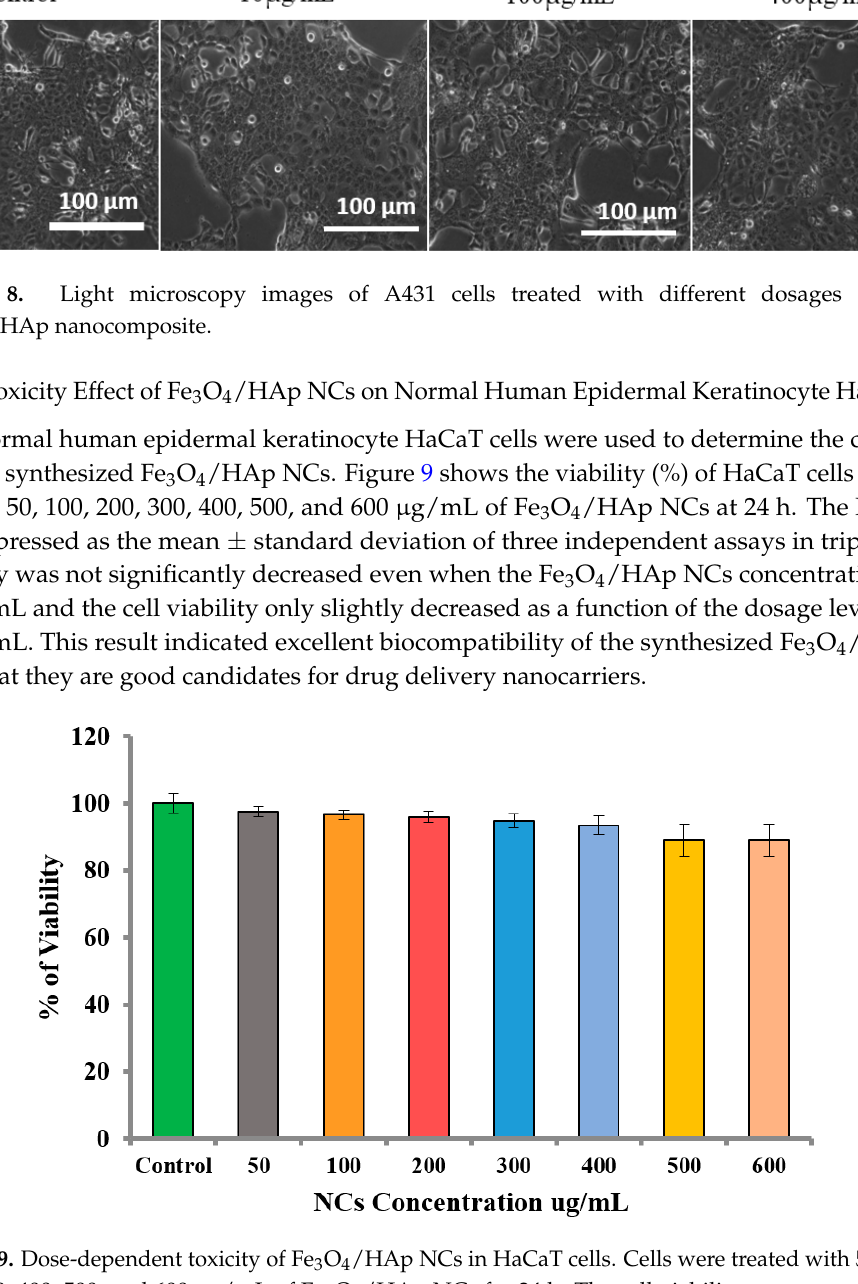
Figure 9. Dose-dependent toxicity of Fe 3 O 4 /HAp NCs in HaCaT cells. Cells were treated with 50, 100, 200, 300, 400, 500, and 600 µ g/mL of Fe 3 O 4 /HAp NCs for 24 h. The cell viability was measured by 200, 300, 400, 500, and 600 μ g/ mL of Fe 3 O 4 /HAp NCs for 24 h. The cell viability was measured by MTT assay in MTT assay in triplicate.